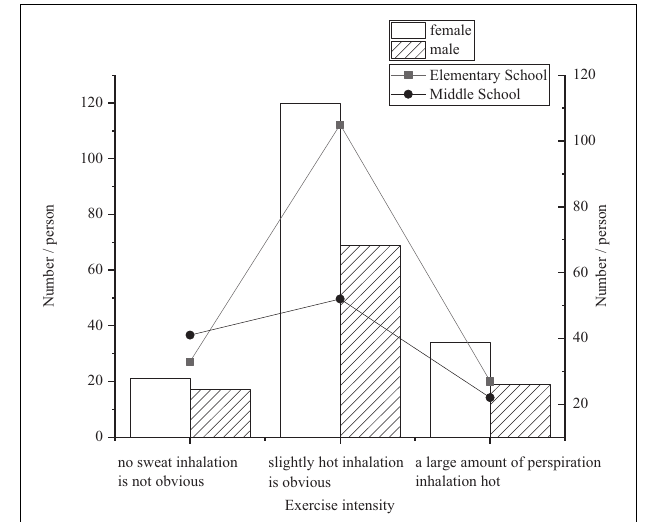
FIGURE 5 | Physical exercise intensity survey of primary and middle school